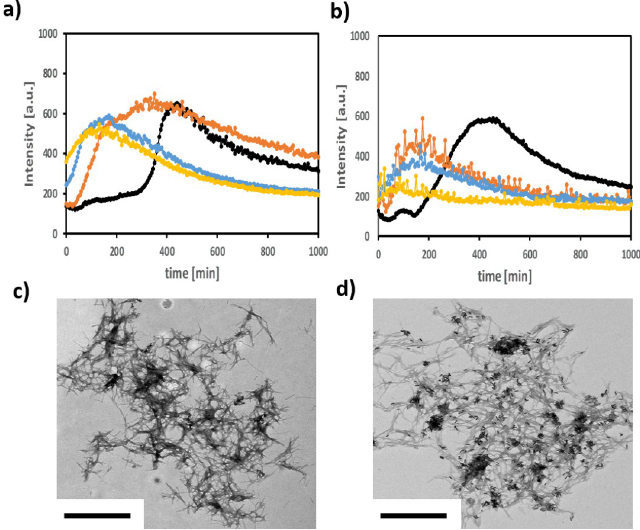
Fig 5. Seeds-Abs-GNRs complexes retain seeding ability and can be integrated into fibrillar networks. a) Aggregation kinetics assessed by ThT fluorescence of 10 μ M A β 40in PBS (pH 7.4, 37˚C) in absence (black) or presence of seeds at varying concentrations; 0.1 μ M(orange), 0.5 μ M(light blue), and 1 μ M (yellow). b) ThT fluorescence of 10 μ M A β 40incubated in absence (black) or presence of pre-formed seeds-Abs-GNRs formed from 0.4 nM of Abs-GNRs with increasing concentrations of seeds as above 0.1 μ M(orange), 0.5 μ M(light blue), and 1 μ M(yellow). TEM images of 10 μ MA β 40incubated in PBS, pH 7.4 for 10 h at 37˚C in the presence of c) plain seeds and d) seeds-Abs-GNRs, confirming that seeds-Abs-GNR complexes are integrated within fibrillar networks. Scale bars correspond to 1 μ m.